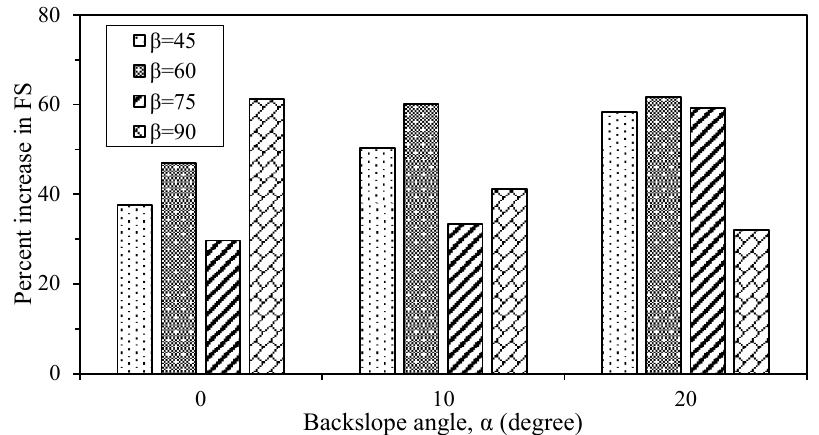
Figure 16. Percent increase in FS for various slope geometries due to soil nailing with optimum nail parameters.